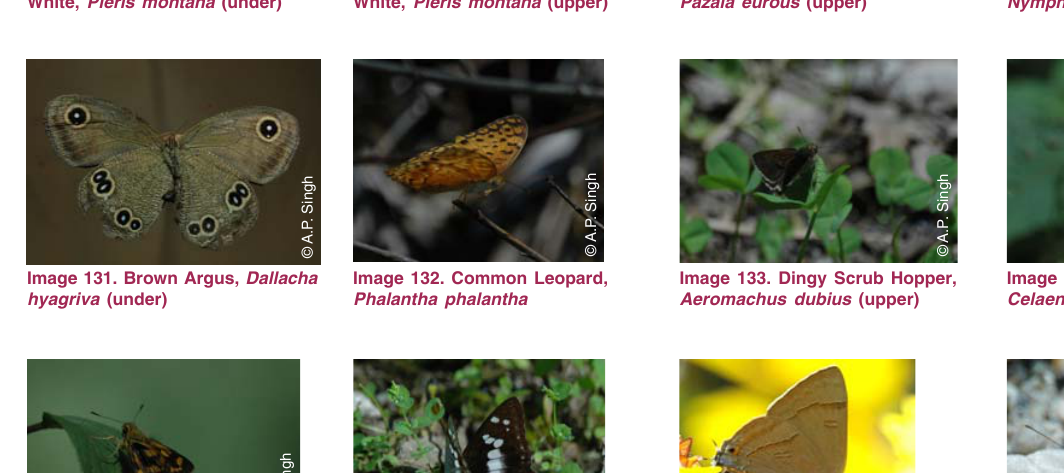
Image 130. Large Tortoiseshell, Nymphalis xanthomelas (upper)